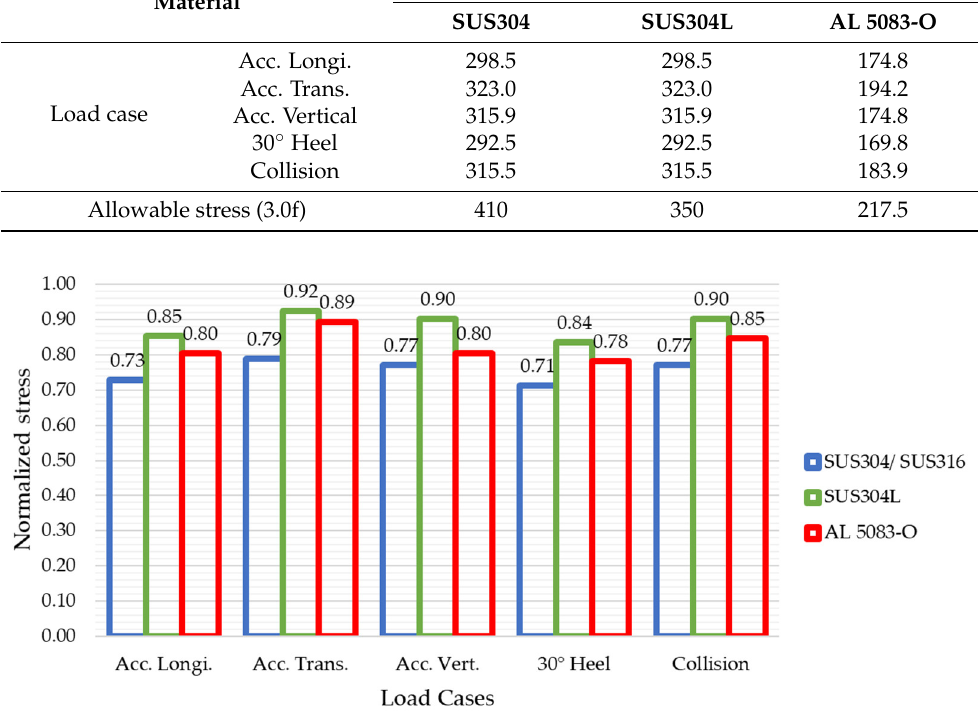
Figure 15. Comparison of normalized stresses for different materials.